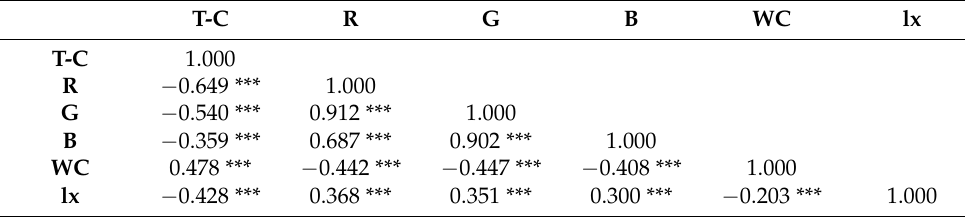
Table 2. Pearson correlation coefficient table of the PS soil components.